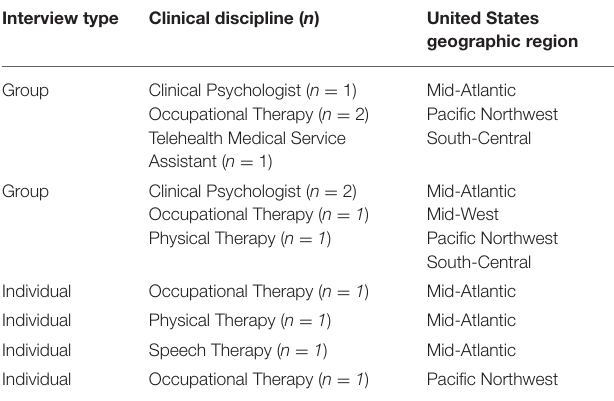
TABLE 1 | Interviewee